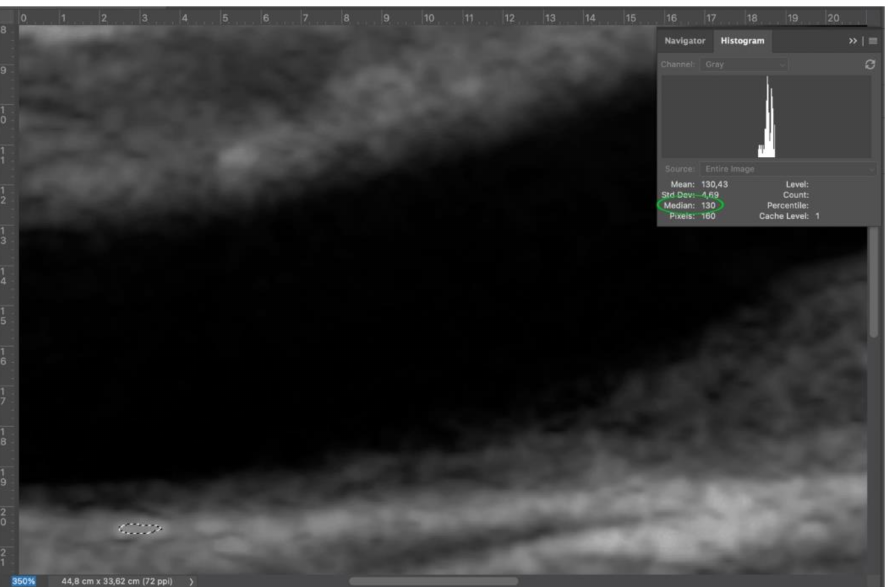
Figure 3. Step 2: select an adequate area of adventitia (dashed white circle), since it represents the key to perform a correct